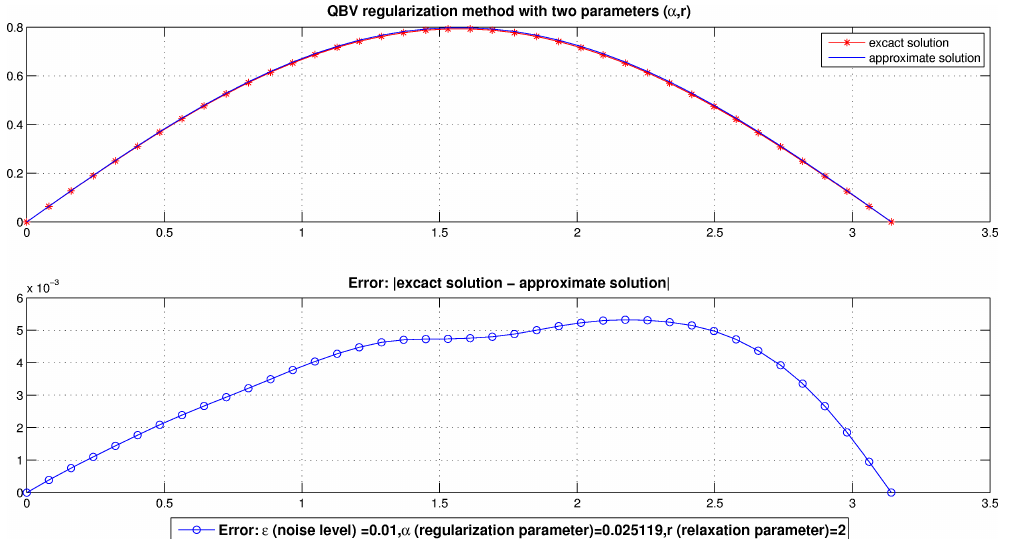
Fig. 7. ε (noise level) =0.01, α (regularization parameter)=0.025119, r (relaxation parameter)=2